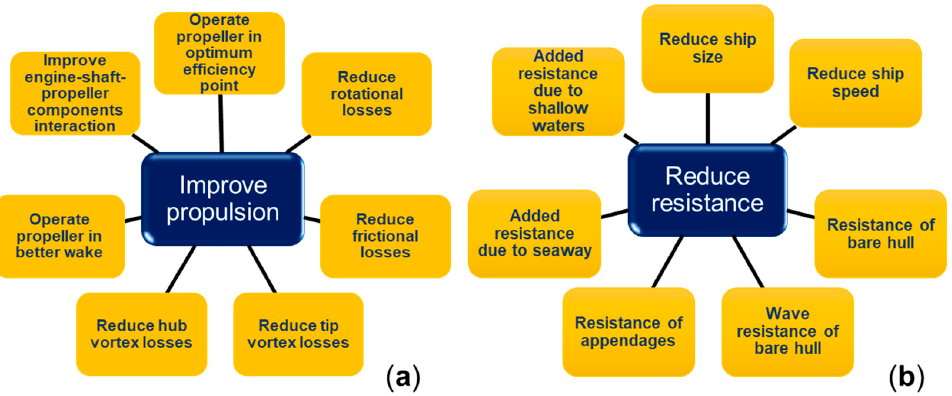
Figure 1. Factors that will reduce the power required for propulsion (a) by improving propulsion and (b) by reducing resistance. Adapted from [22].